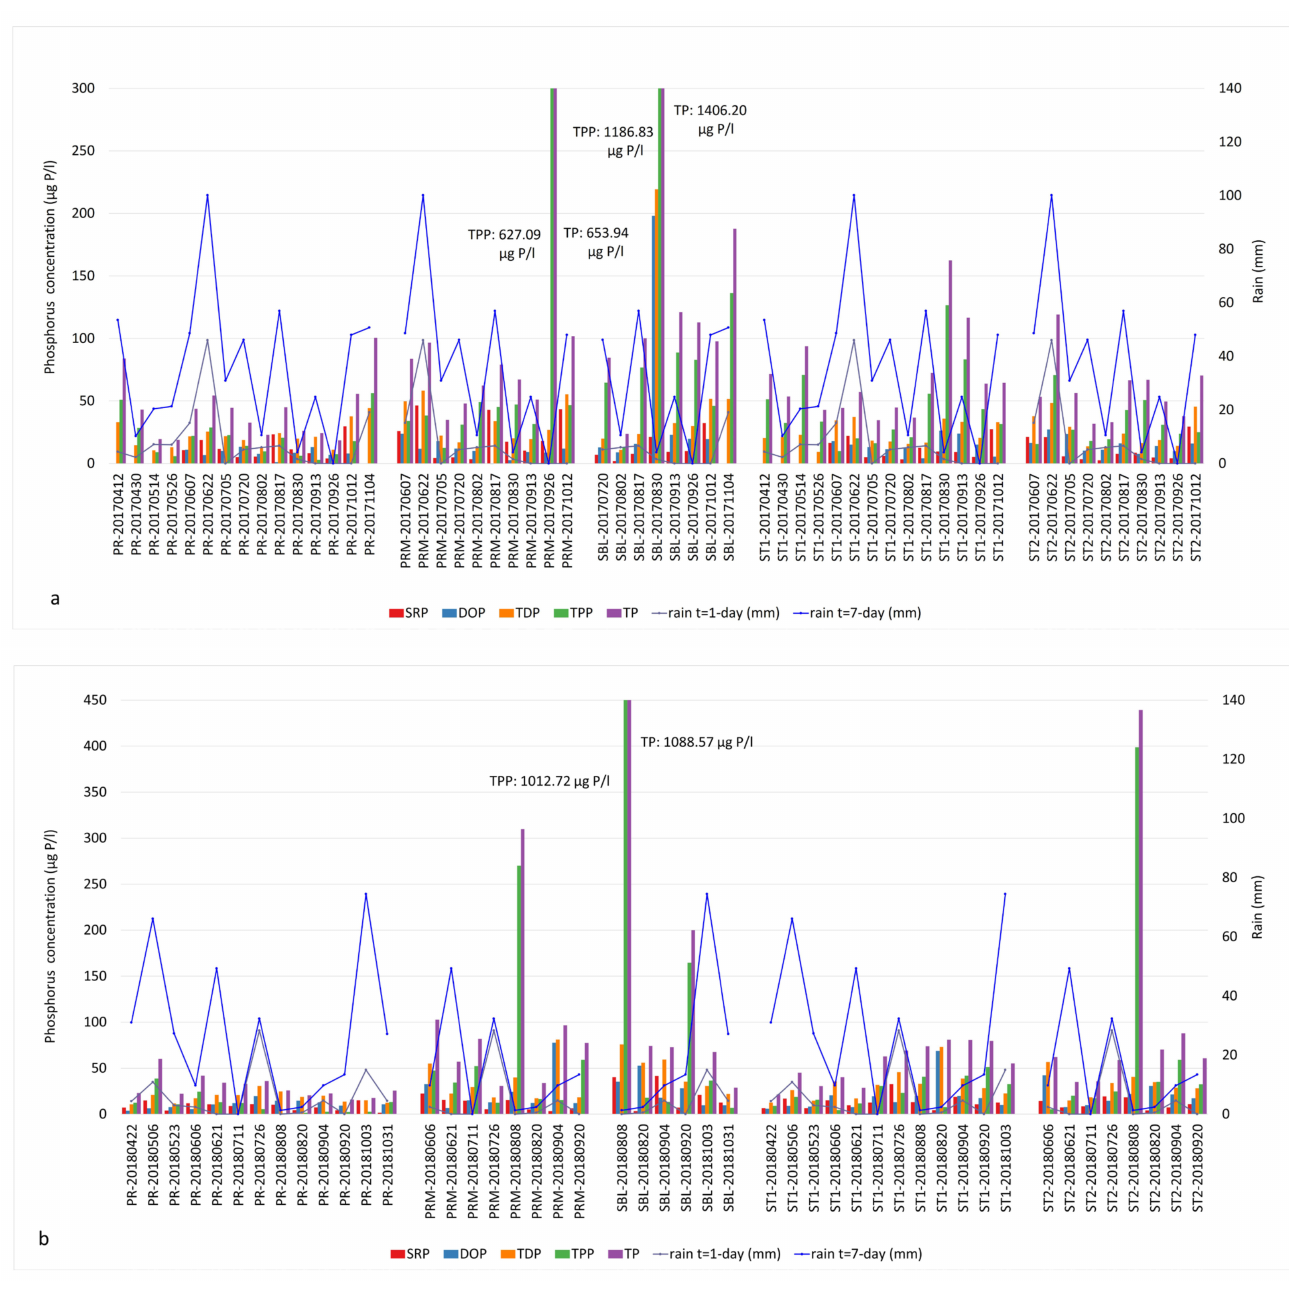
Figure 4. Phosphorus fractions and cumulative precipitation identified in Missisquoi Bay during ( a ) 2017 and ( b ) 2018 sampling campaigns. Extreme TPP values corresponded to intense bloom episodes. Concentrations exceeding the value axis are indicated in the text